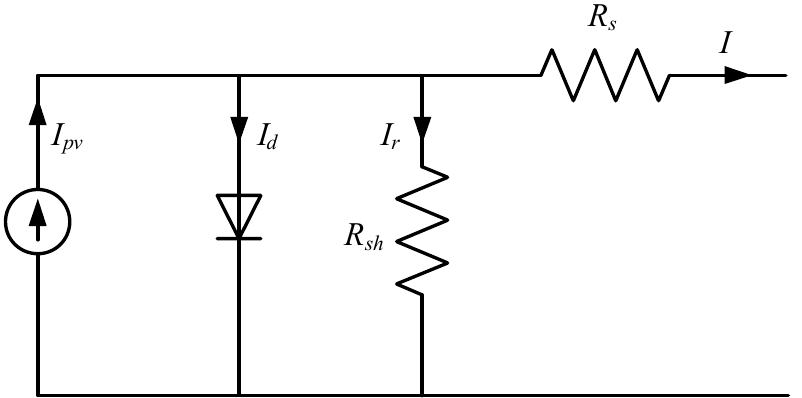
Table 1. Electrical characteristics of Shell SP150-P module at standard test conditions (STC). Parameter